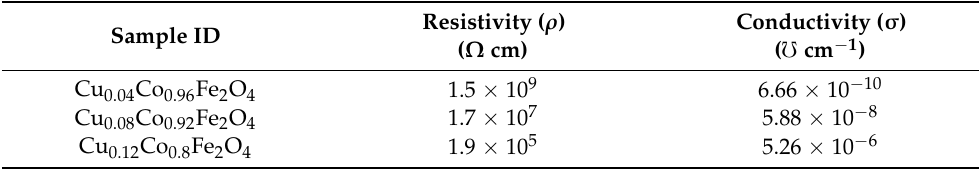
Table 3. Electrical characteristics of Cu 2+ -doped CFO nanoparticles.